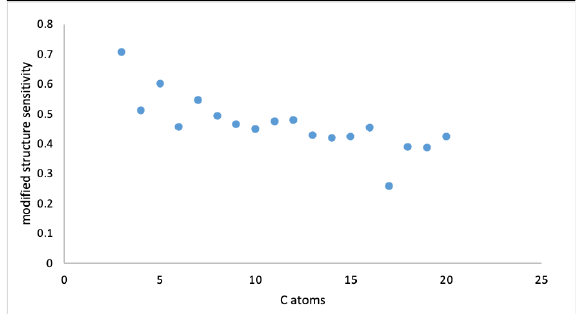
Figure 8. Distribution of modified structure sensitivity of graph energy.